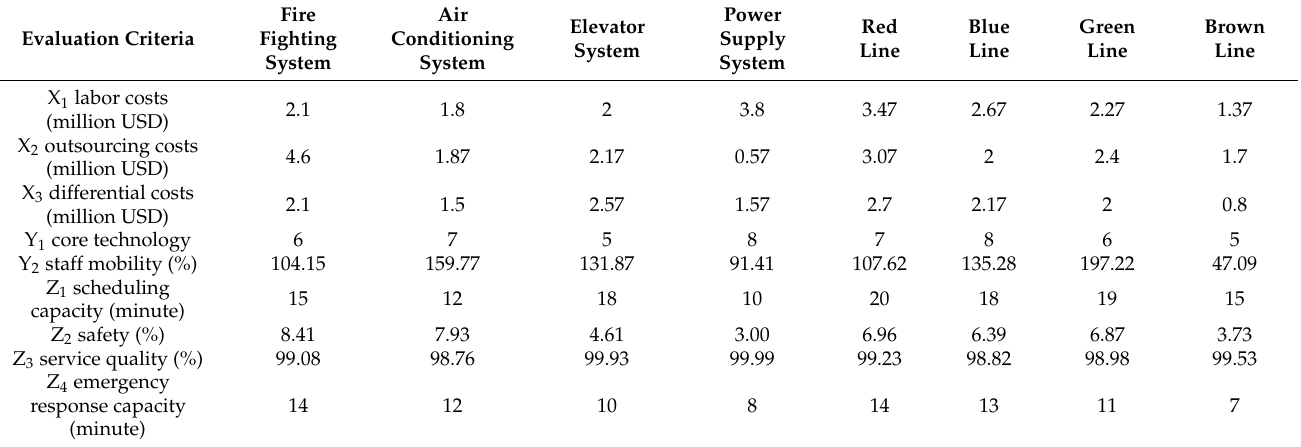
Table 2. Basic information on the actual outsourcing work of the four subsystems of the electrome- chanical system and the four lines of the metro